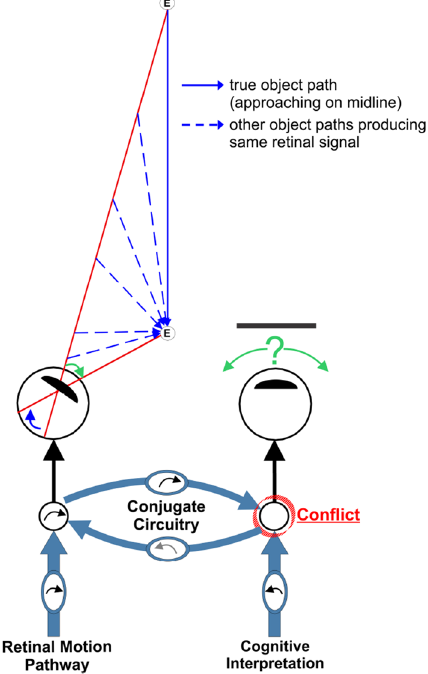
Figure 5. Controlling occluded eye rotations. Retinal motion in the viewing eye is ambiguous and the target’s depth component is interpreted from monocular depth cues. A vergence command is issued to the covered eye, which conflicts with a conjugate command issued from the viewing eye. Resolution of the conflict determines covered eye